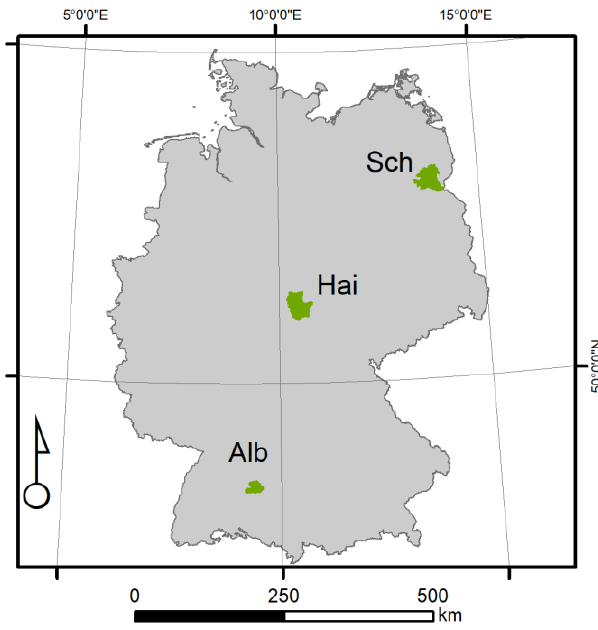
Figure 2: Location of the three BE: Schorfheire, Hainich, and Schwäbische Alb.